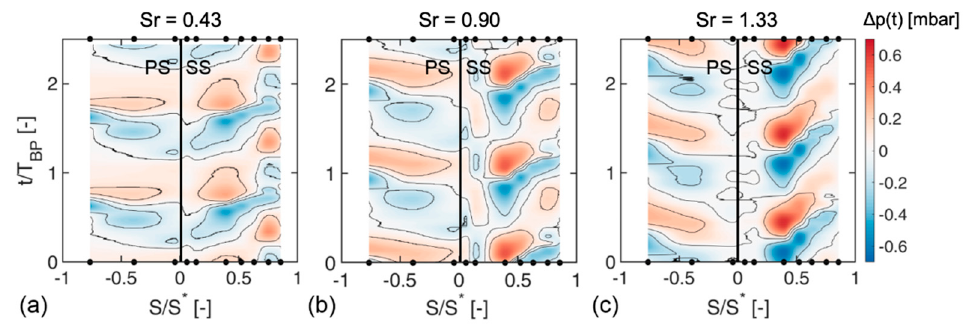
Figure 30. Temporal evolution of pressure fluctuations along the T106 RUB profile at midspan for Sr = 0.43 ( a ), Sr = 0.90 ( b ) and Sr = 1.33 ( c ), see [58].